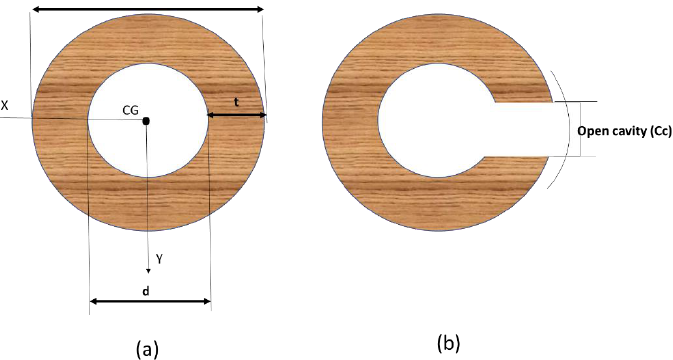
Figure 1. Schematic representation of a disc with a circular and concentric cavity ( a ) and disc with an open cavity ( b ). D = diameter of the disc, d = diameter of the cavity, t = residual wall thickness, Cc = circumference of the open cavity.